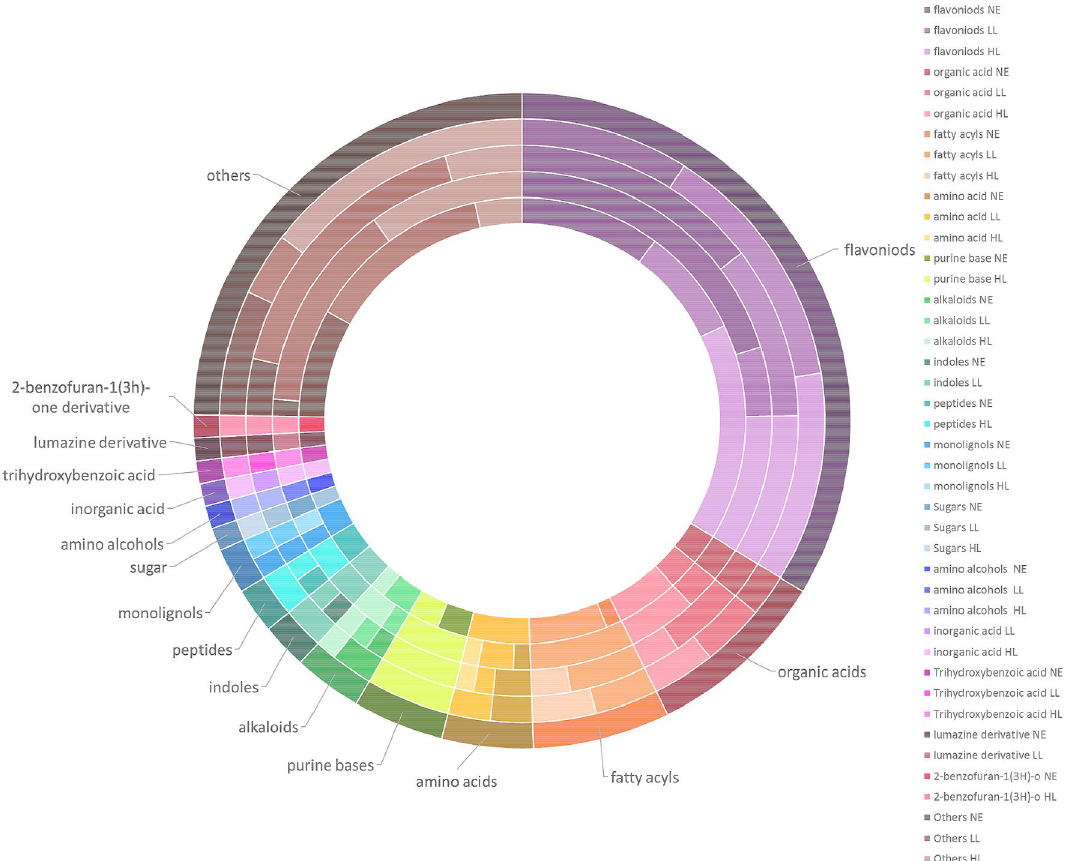
Figure 1. Pie chart depicting percentages of the 89 putatively identified metabolites from each of the metabolite groups, as well as the regulation of the metabolites of each group in response to the different temperature conditions. Each of the layer indicate a Nepenthes species, from inner layer to outer layer: N. minima , ampullaria , northiana , rafflesiana . NE no effect/particular pattern, LL metabolites expressed highest at lowland condition, HL metabolites expressed highest at highland